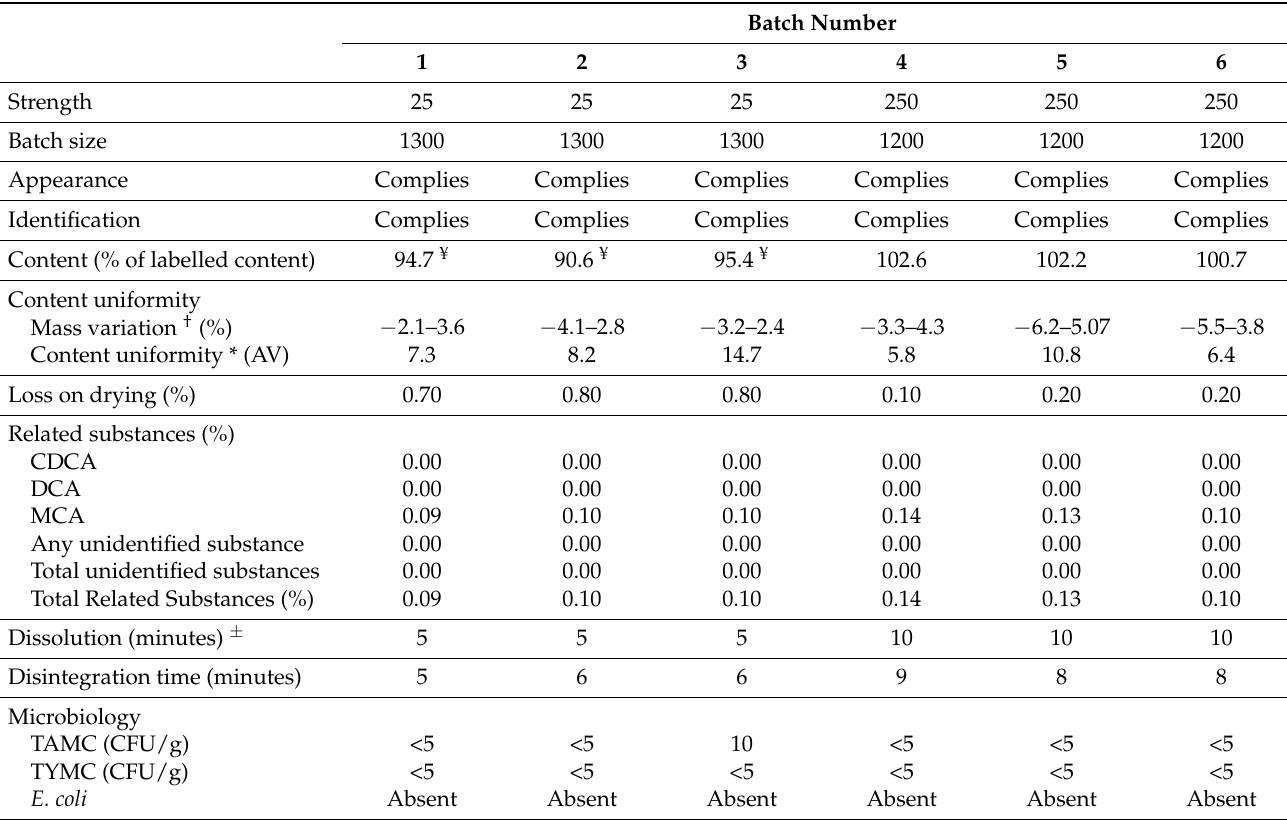
Table 3. Results of the product validation of 25 mg and 250 mg CA capsules.